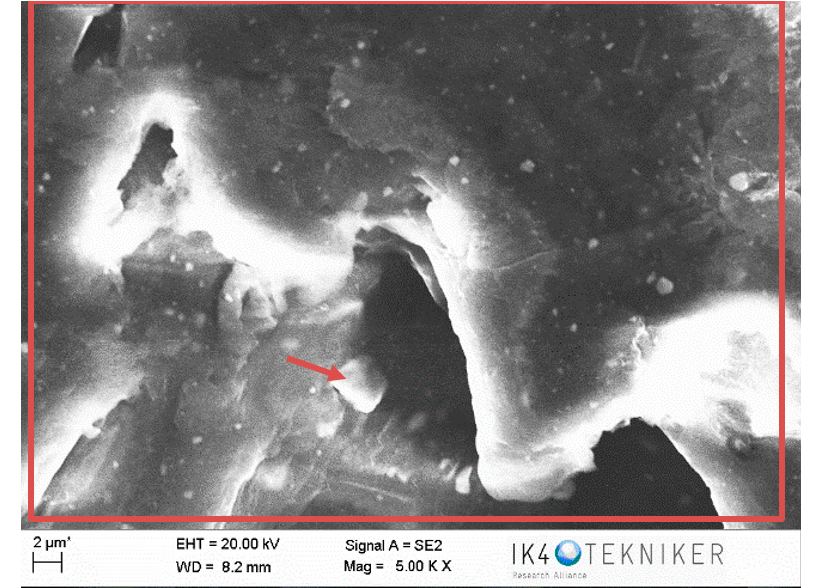
Figure 13. SEM image for zone 1 in the PA46Z sample.